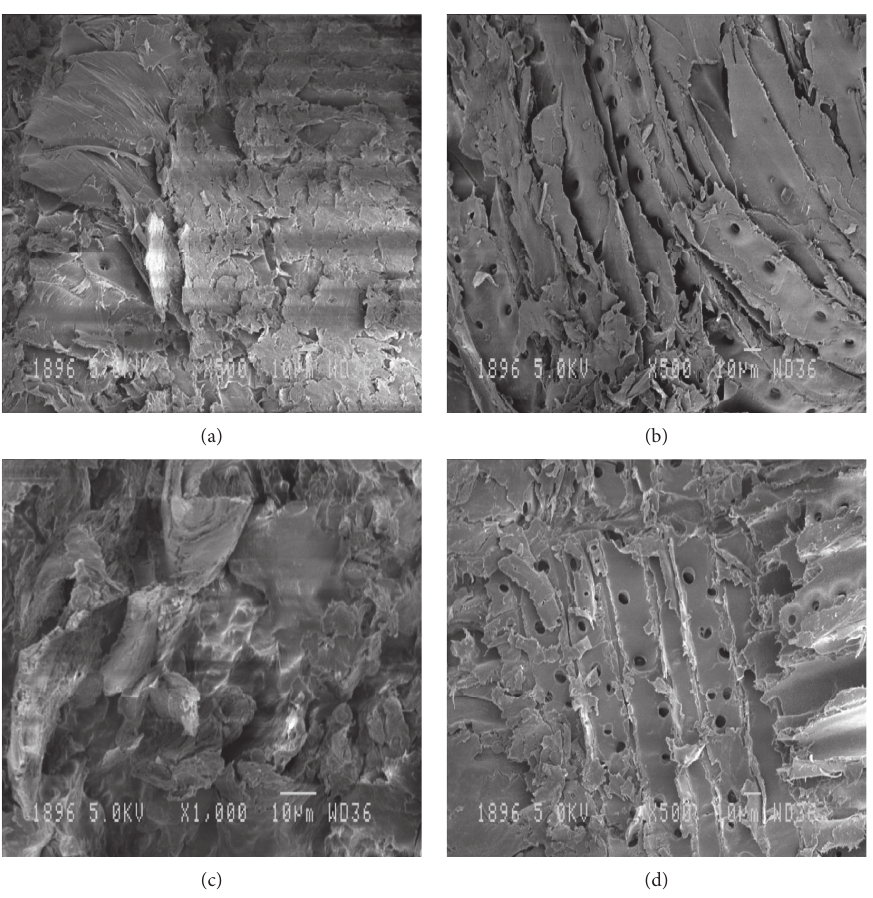
Figure 2: SEM image of (a) pinus - raw and (b) pinus-g-( AN/EA ).